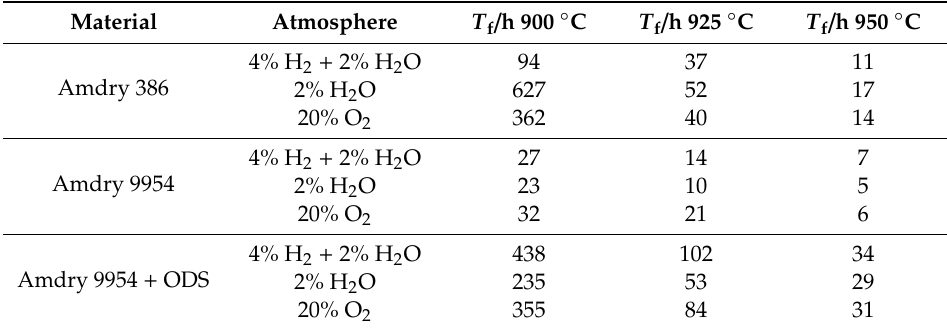
Table 2. Time to failure T f for Amdry 386, Amdry 9954 and Amdry 9954 + ODS annealed in di ff erent atmosphere after creep experiments at 900–950 ◦